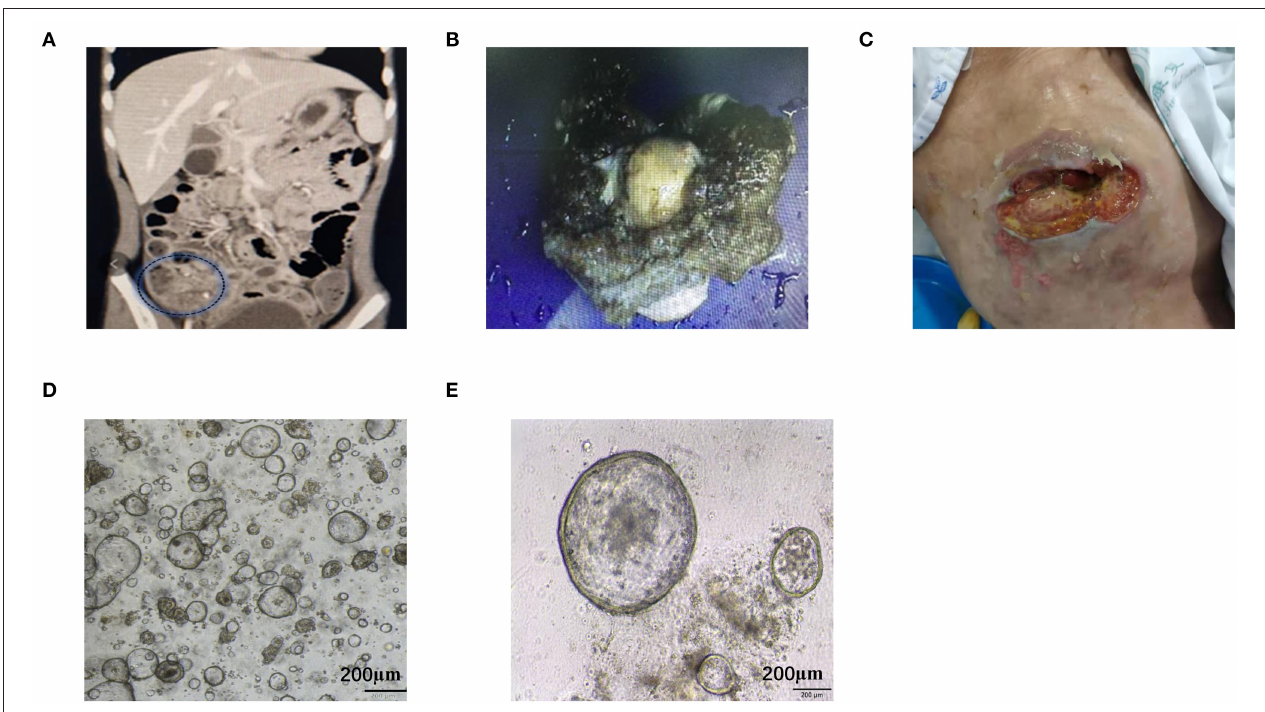
FIGURE 1 | Representative images of the clinical course of the MAA patient. (A) Abdominal CT scan showed right lower abdominal mass with ascites. (B) Intraoperative specimens suggested that the tumor had invaded the serous membrane with massive mucinous infiltrations. (C) Metastatic tumor in abdominal wall stoma. (D,E) Stably passaged organoids appear spherical with different sizes. Scale bar = 200 µ